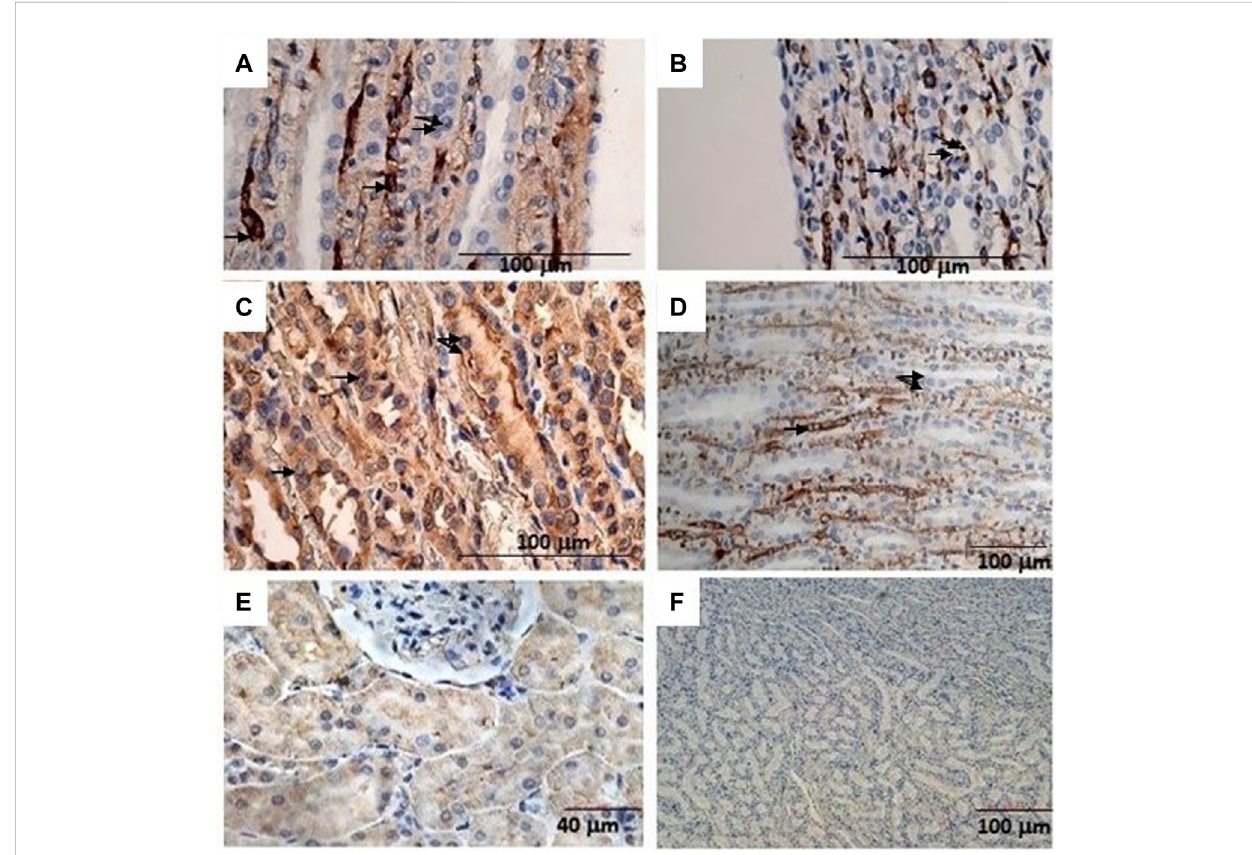
FIGURE 4 (A) Sur1 immunohistochemical detection localized in the cytoplasm and plasma membrane of renal cancer cells; double arrows indicate normal cells, and a single arrow indicates abnormally stained cells. Bar = 100 μ m, 40X. (B) Kir6.1 immunohistochemical detection localized in the basal areas of cells(singlearrow),normalcells(doublearrows).Bar=100 μ m,40X. (C) AbnormalSur2Aimmunohistochemicaldetectionlocalizedinthecytoplasmand plasma membrane showing > 50% of positive cells vs. control. Bar = 100 μ m, 40X. (D) Kir6.2 immunohistochemical localized in the basal areas of cells was found (single arrow) and in normal cells (double arrows). Bar = 100 μ m, 10X. (E) Typical immunohistochemical staining with the primary mAb in the cytoplasm of the tubules used as a positive control for Sur2A in a non-cancer rat kidney section. Bar = 40 μ m, 40X. (F) A rat renal section with no primary mAb was used as a negative control. Bar = 100 μ m,